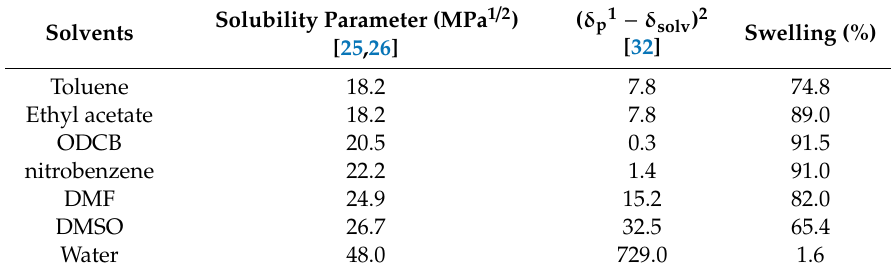
Table 2. Data of solubility parameter of solvents and the degree of swelling of PLLA.